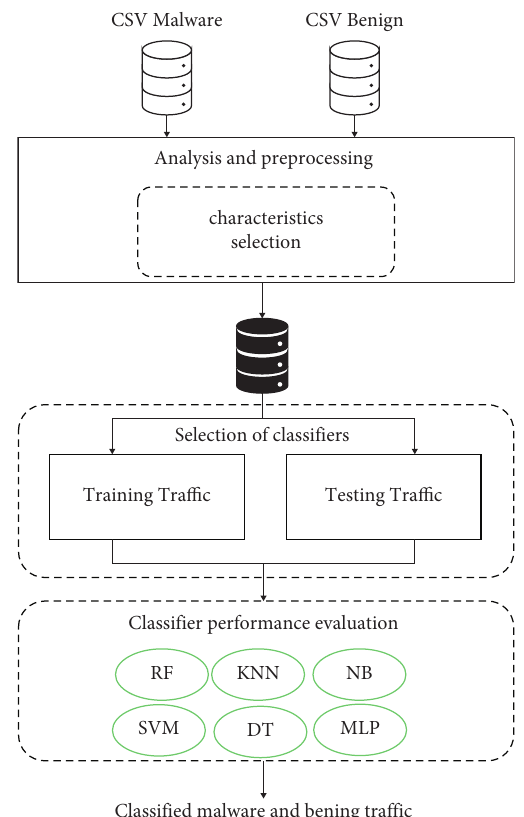
Figure 1: Four phases that are part of a standard machine learning